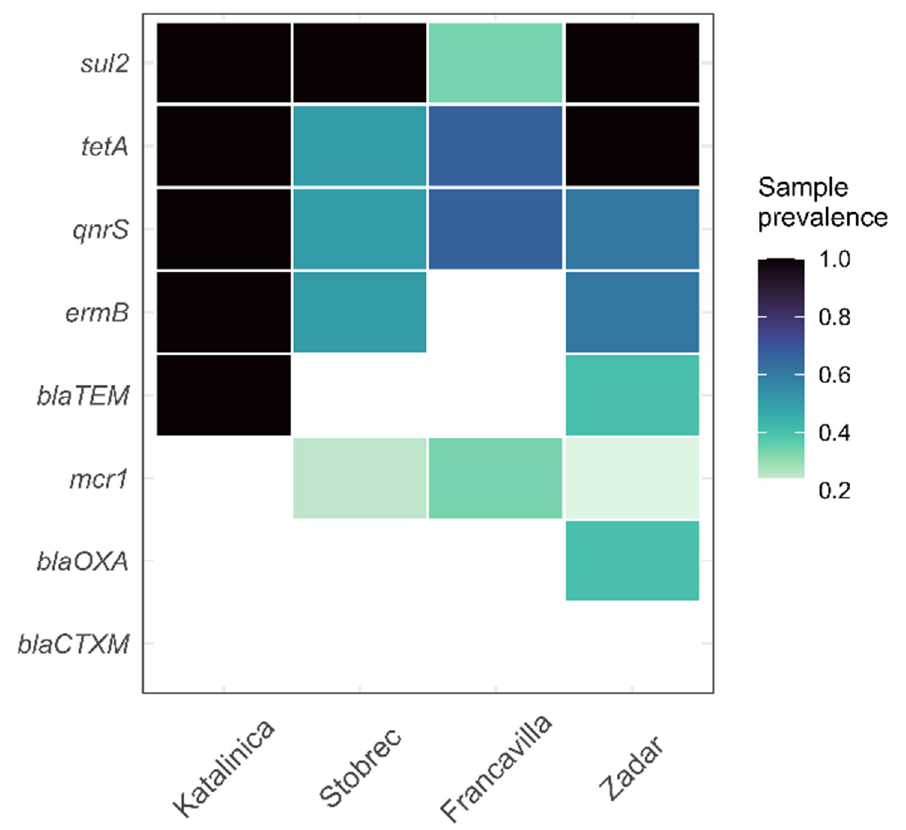
Figure 6. Sample prevalence ratio (% of samples positive for a given gene) of ARGs in seawater samples. As the content of the ARGs investigated in this study was often not quantifiable, observations were converted as presence/absence data and then plotted as prevalence ratio.